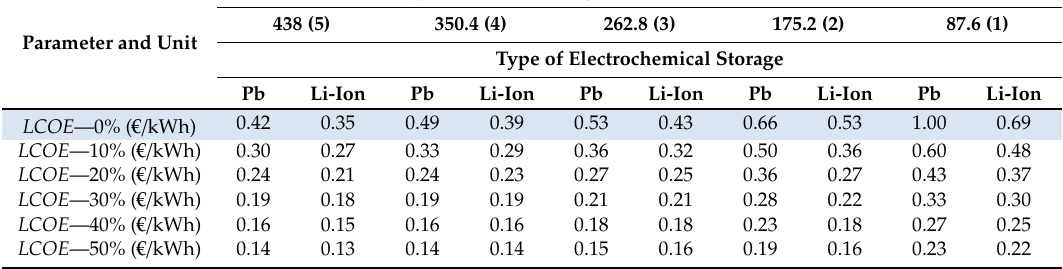
Table 10. Comparison of optimization results ( LCOE ) of a structure of a PV-wind hybrid power supply system for a 50 kW peak power of industrial load and Pb and Li-Ion batteries (current parameters and prices) for the cases of using 10%, 20%, 30%, 40% and 50% of the energy emitted on the heaters during heating of